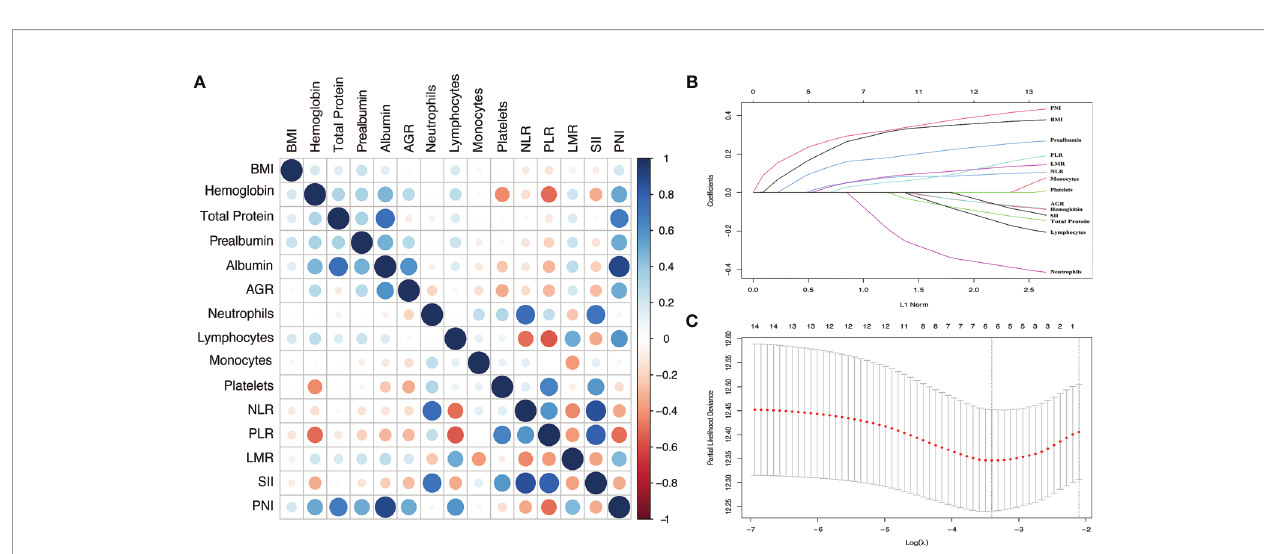
FIGURE 2 | Construction of the INPS using LASSO Cox regression model. (A) A correlation matrix is represented from R=-1 negative correlation (red) to R=1 positive correlation (blue). (B) LASSO coef fi cient pro fi les of the 15 nutritional and In fl ammatory biomarkers. (C) Ten-fold cross ‐ validation for tuning parameter selection in the LASSO model. The dotted vertical lines were drawn at the optimal values by minimum criteria and 1-SE criteria. Solid vertical lines represented partial likelihood deviance ± SE. Herein, a value l = 0.033 with log ( l ) = -3.411 was chosen via minimum criteria. INPS, in fl ammatory-nutritional prognostic score; SE, standard error; BMI, body mass index; AGR, albumin-globulin ratio; NLR, neutrophil-lymphocyte ratio; PLR, platelet-lymphocyte ratio; LMR, lymphocyte-monocyte ratio; SII, systemic immune in fl ammation index; PNI, prognostic nutritional